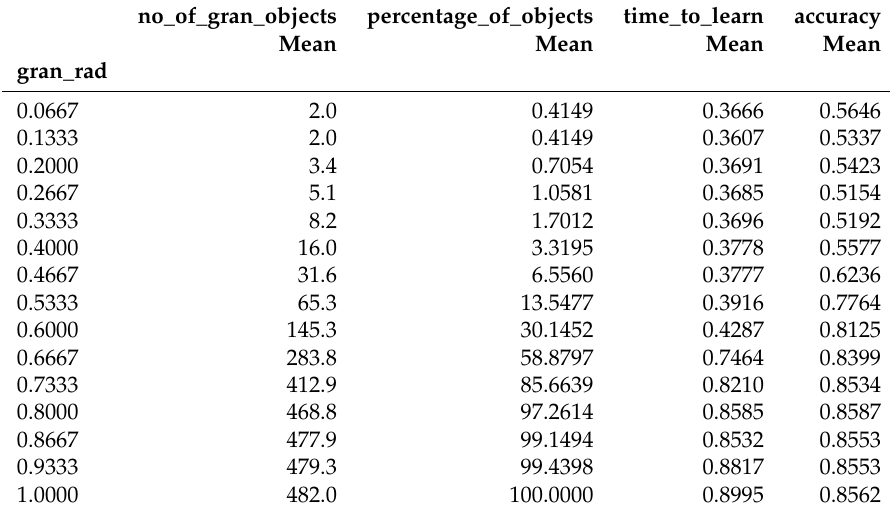
Table 5. Results for Australian credit dataset (mean from 10 experiments).